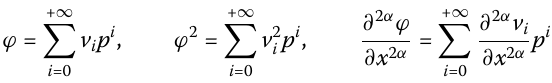
, ( c ) Non-differentiable 2 and ln(2) , ( e ) Absolute error 2 ln(3) , ( h ) Absolute error of ln(3)